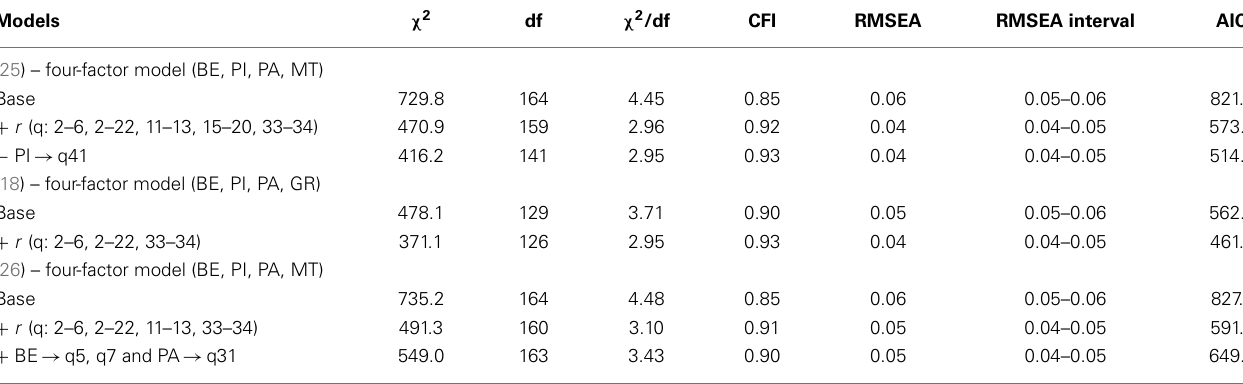
Table 1 | Confirmatory factor analysis: fitting of three different models for the CommunityAssessment of Psychic Experiences – positive symptoms dimension